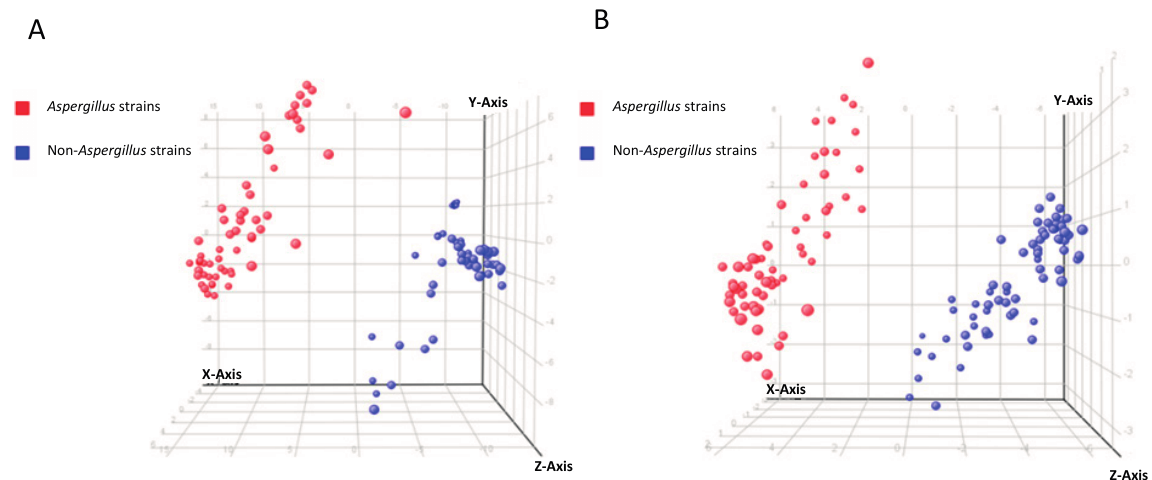
Figure 3. PLS-DA t-score plots of 128 fungal culture supernatant samples. ( A ) Positive ionization mode; ( B ) negative ionization mode.